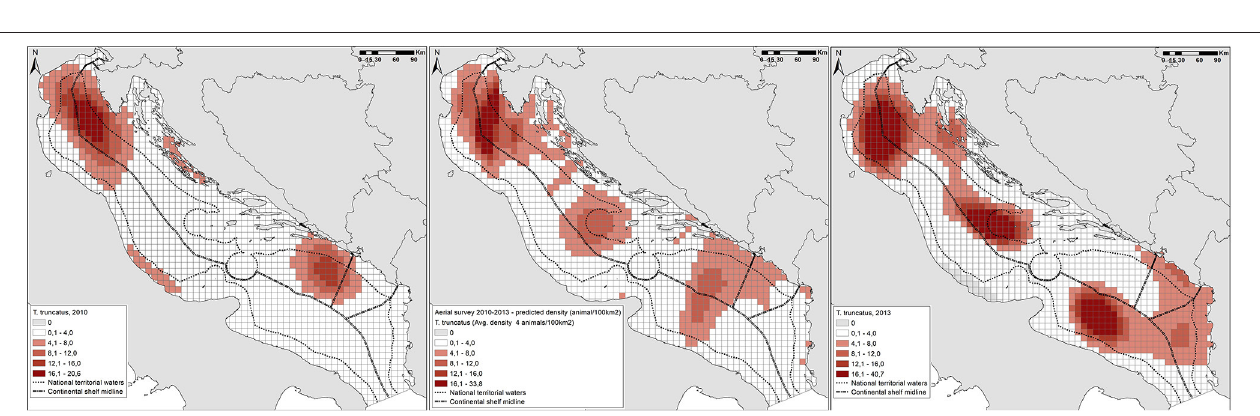
FIGURE 3 | Bottlenose dolphin densities for the data from 2010 (left); 2010–2013 (center), and 2013 (right). The scales represent below average (white), and then up to twice, up to three times, up to four times and greater than four times the average (shades of dark red).